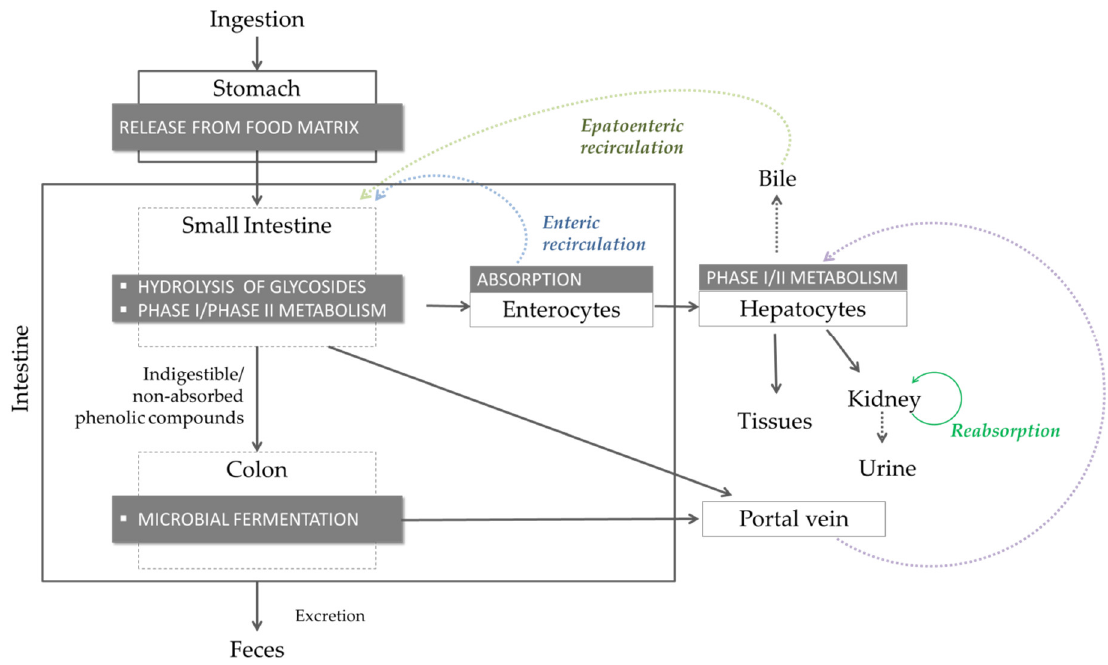
Figure 2. Representation of digestion, absorption and excretion of phenolic compounds and metabolites